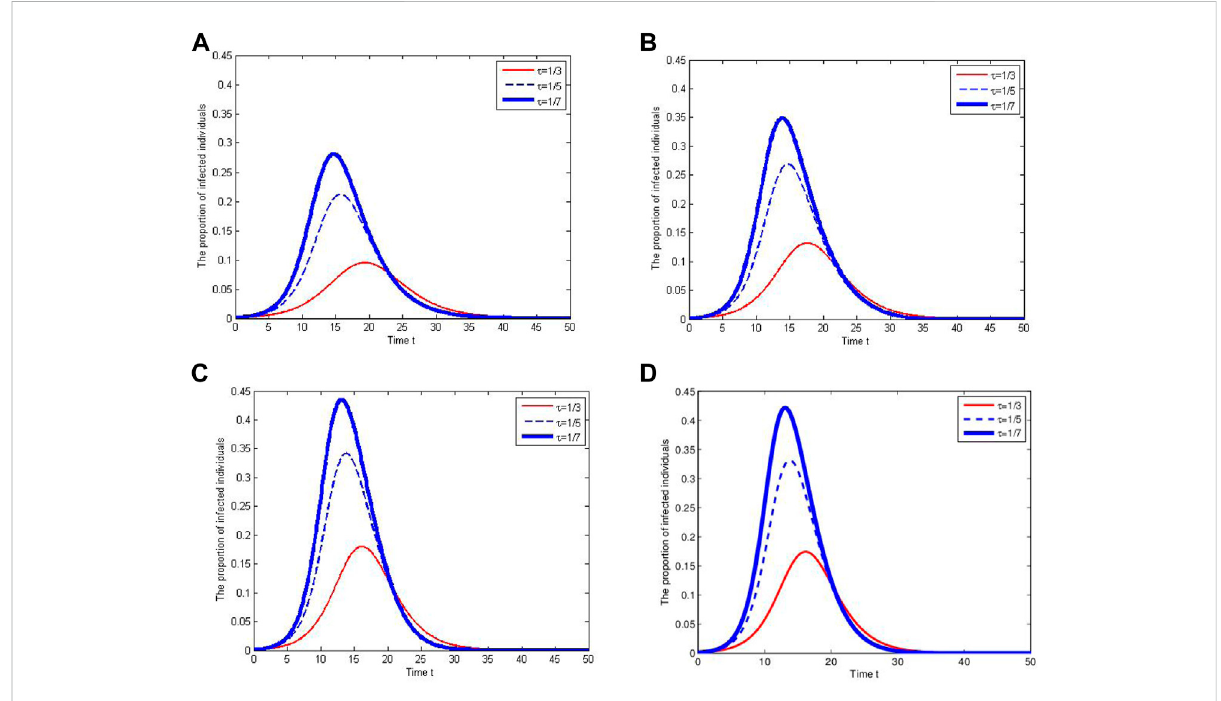
FIGURE 4 Effects of different contact tracing rates and awareness processes on the infection proportion. The awareness process follows the distribution E (10) in (A) , U (0, 20) in (B) , Gamma (10, 1) in (C) and Gamma (5, 2) in (D) , respectively. Here, E (10), U (0, 20), Gamma (10, 1) and Gamma (5, 2) have the same mean but different